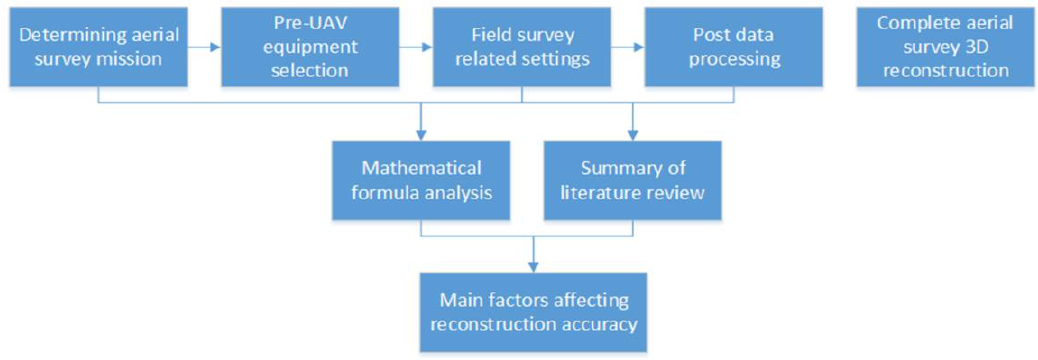
Figure 2. Analysis Chart of Main Influencing Factors on Reconstruction Accuracy